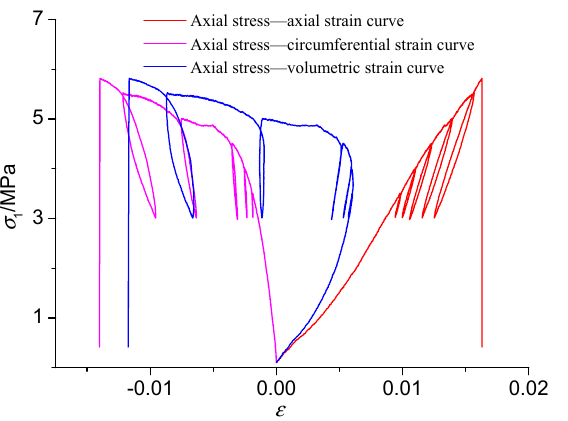
Figure 2. Relation curves between axial, circumferential, and volumetric strains and axial stress.